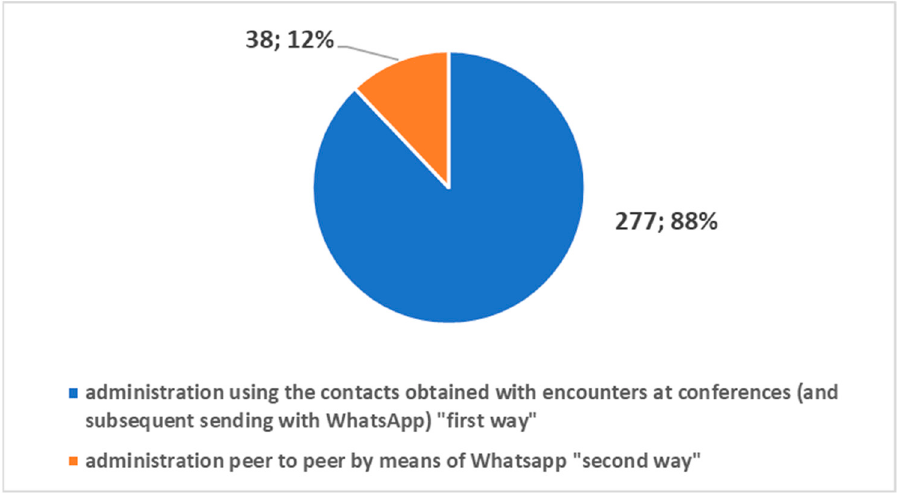
Figure 4. Contributions to the survey by the two different methods.